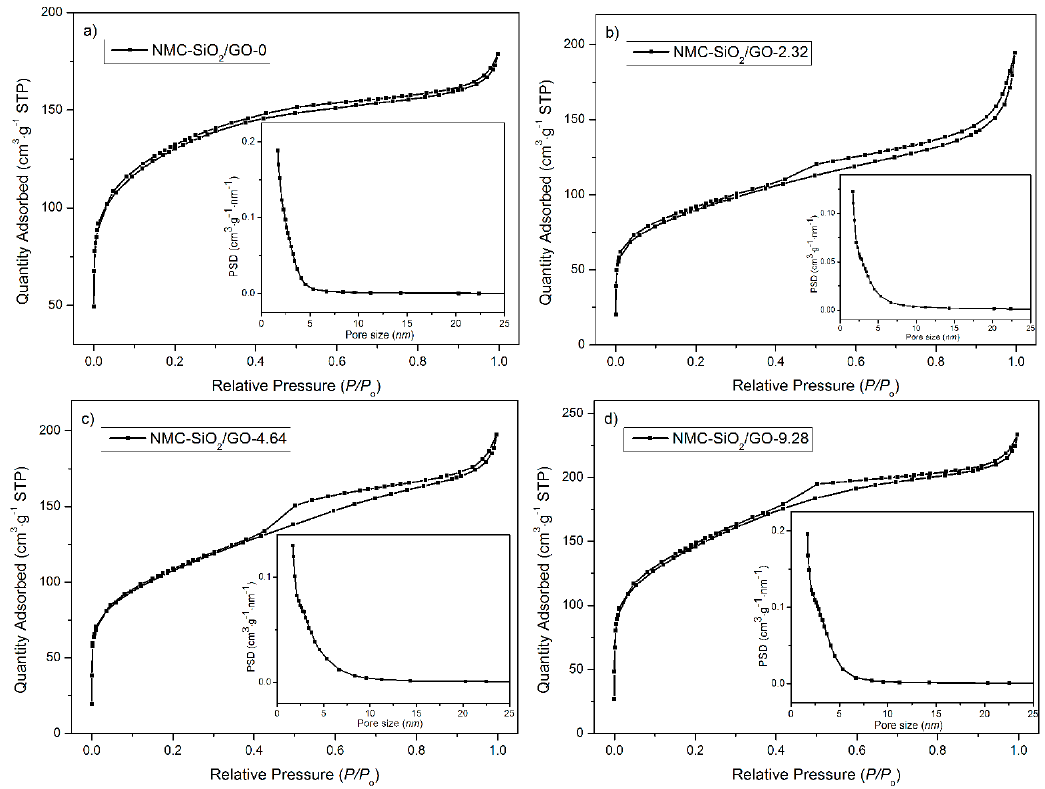
Figure 4. Nitrogen ad/desorption isotherms of the synthesized carbon (NMC)-SiO 2 /GO- x : ( a ) x = 0; ( b ) x = 2.32; ( c ) x = 4.64; ( d ) x = 9.28 . Table 1. Pore features of the synthesized carbon.